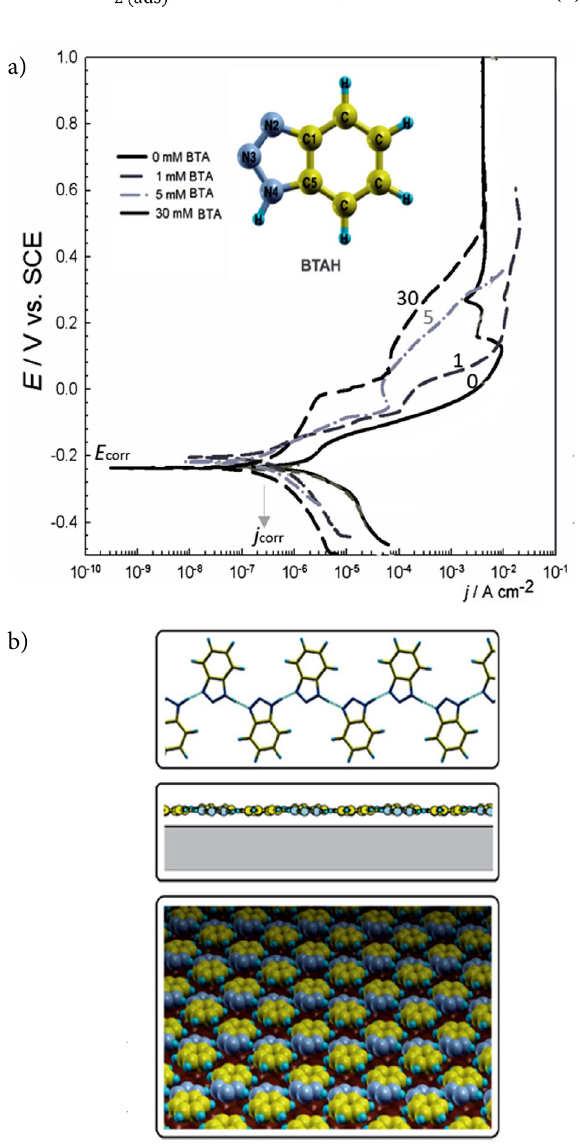
Figure 5. (a) Polarization curves recorded for copper in 0.5 M NaCl with and without benzotriazole (BTA) added in concentration of 1, 5 and 30 mM. Scan rate was 1 mV/s. ( Reprinted from the publication by T. Kosec, I. Milošev, B. Pihlar, Appl. Surf. Sci., 2007 ,